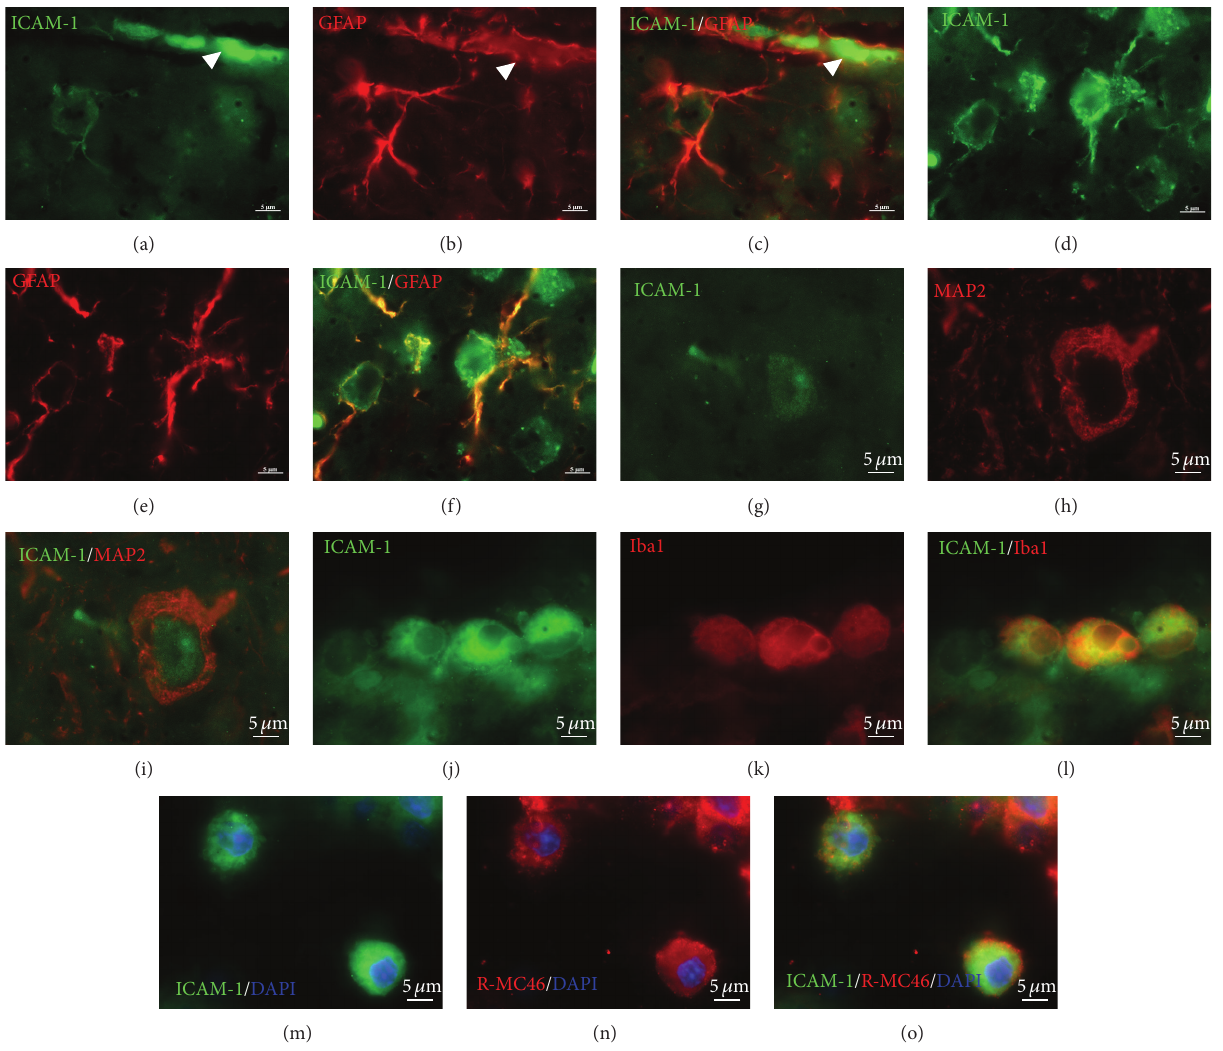
Figure 4: ICAM-1 (green fluorescence) colocalization with different cell types around and within the lesion site. ICAM-1 ((a) and (d)) and GFAP ((b) and (e) red fluorescence) coexpression was found in reactive astrocytes around the blood vessels ((c), arrow head) and in close vicinity to the lesion site (f). Colocalization of ICAM-1 (g) and MAP-2 ((h) red fluorescence) was detected mostly on neuronal cell bodies (i). ICAM-1 (j) colocalized only with activated microglia (Iba1, red fluorescence, (k)) clustered along the border to the lesion site and within the lesion site ((l) yellow fluorescence). Also, ICAM-1 completely overlaps with R-MC46 + neutrophils ((n) red fluorescence) only at the borders and within the lesion core ((o) yellow fluorescence)). Scale bar = 5 𝜇